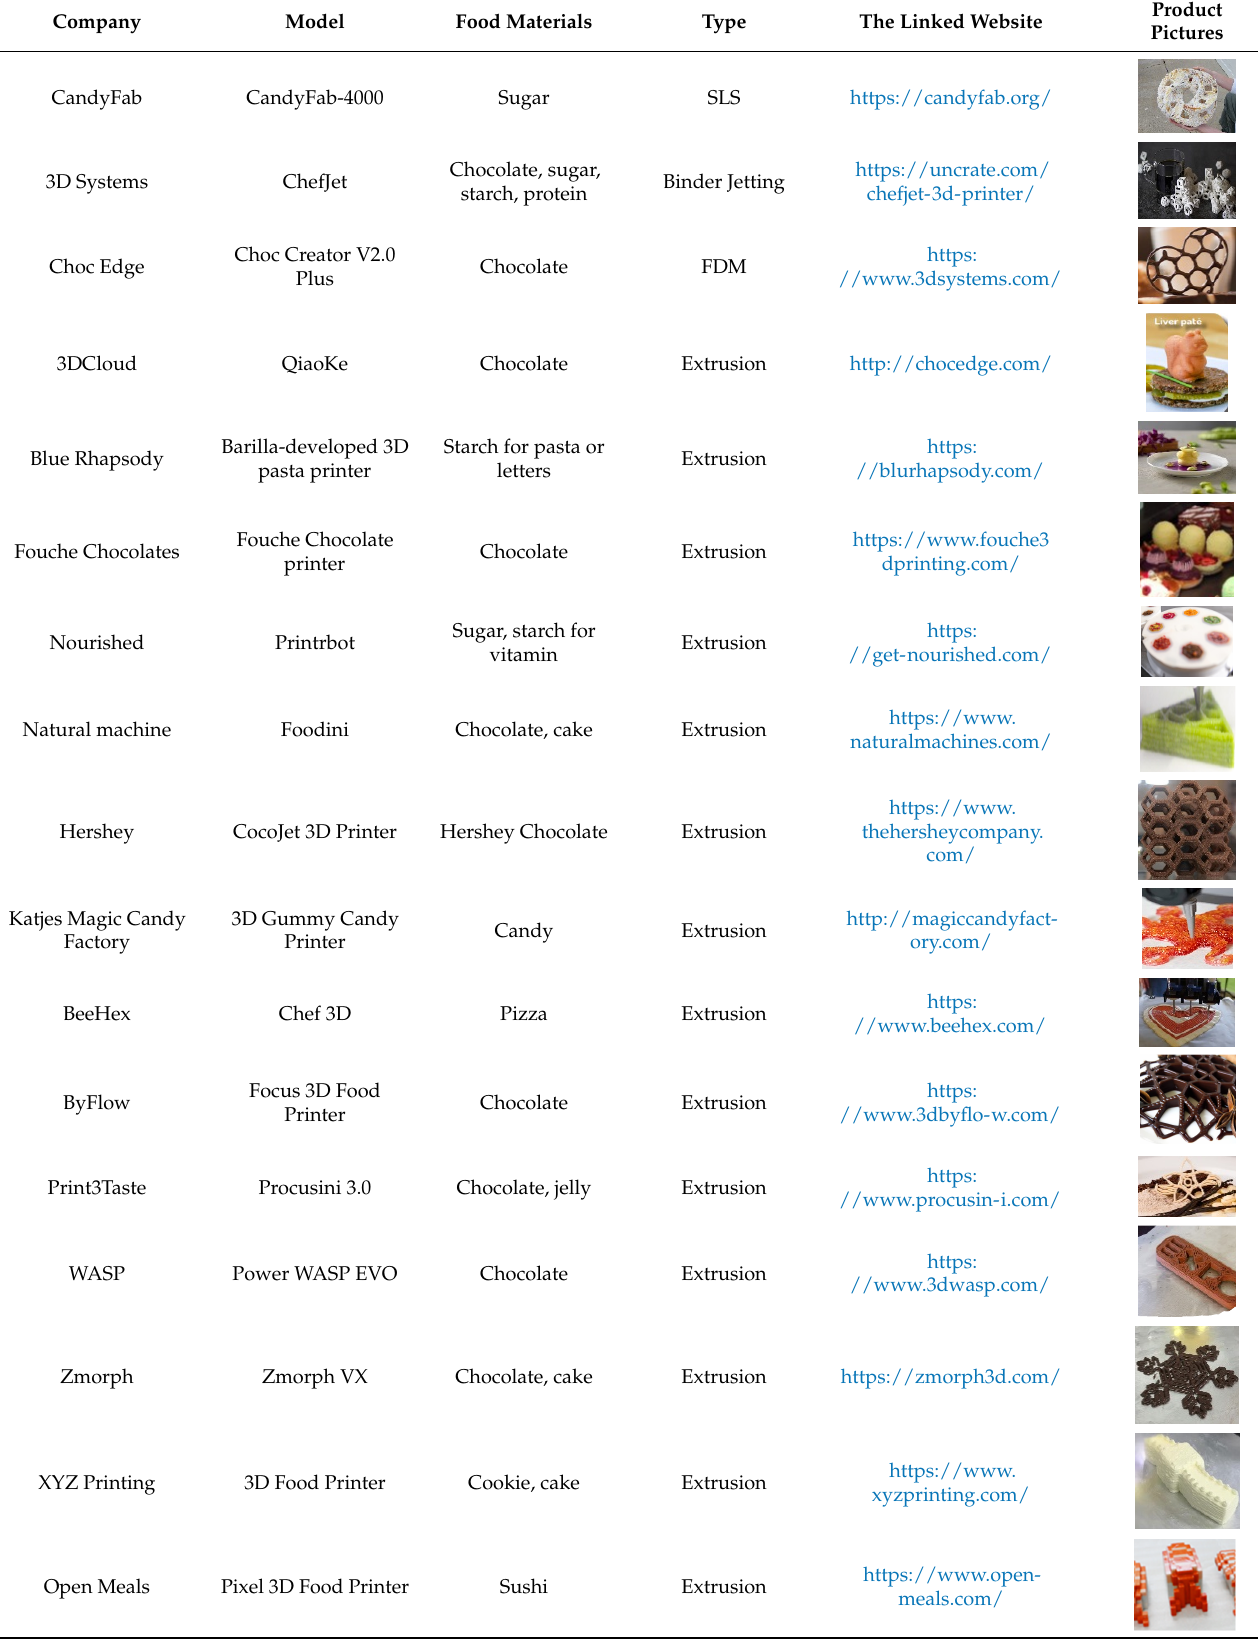
Table 7. Various companies of 3D food printers in food industry.